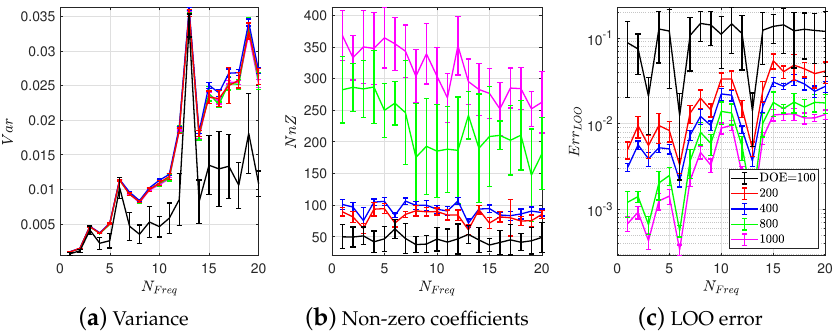
Figure 6. Dam-1; impact of DOE size on the PCE-based surrogate models for frequency